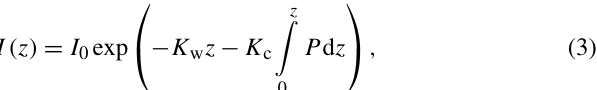
Figure 1. Schematic picture of vertical profiles of nitrate gradient and chlorophyll (Chl a ) in stratified water columns. (Blue solid line is the vertical profile of nitrate gradient; green solid line is Chl a concentration as a function of depth; horizontal green dashed lines indicate the locations of the upper and lower SCML, z m − σ and z m + σ ; horizontal black dotted line indicates the depth of the sur- face mixed layer, z s ; vertical dotted black line represents zero nitrate gradient; z n1 and z n are the locations of extreme nitrate gradients, z n is also the nitracline depth, and z m is the depth of maximum chlorophyll